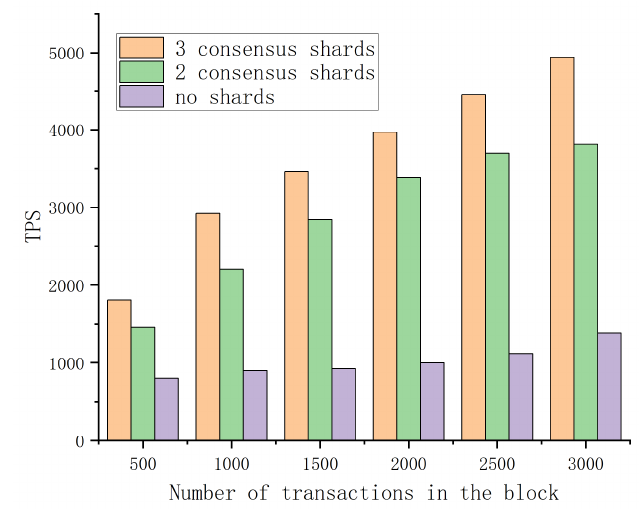
Figure 11. TPS comparison under different shard numbers.